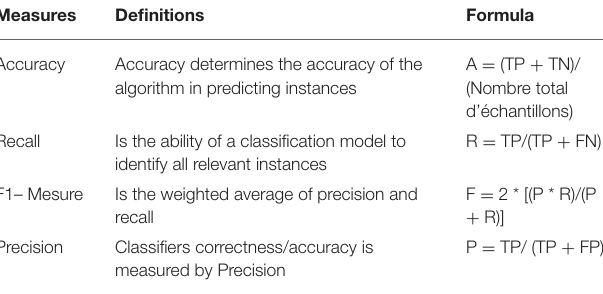
TABLE 2 | Accuracy measures.